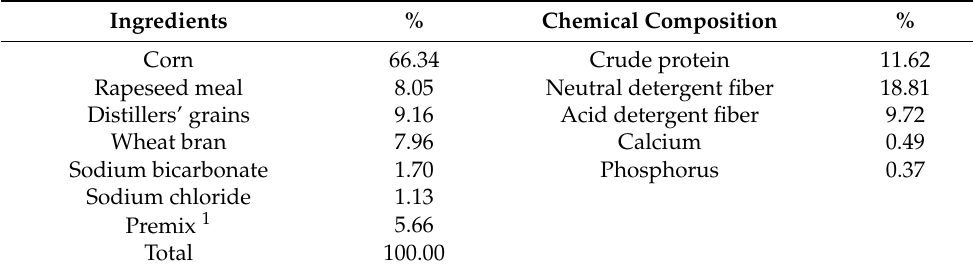
Table 1. Ingredients and chemical composition of the fermentation substrate in vitro (DM